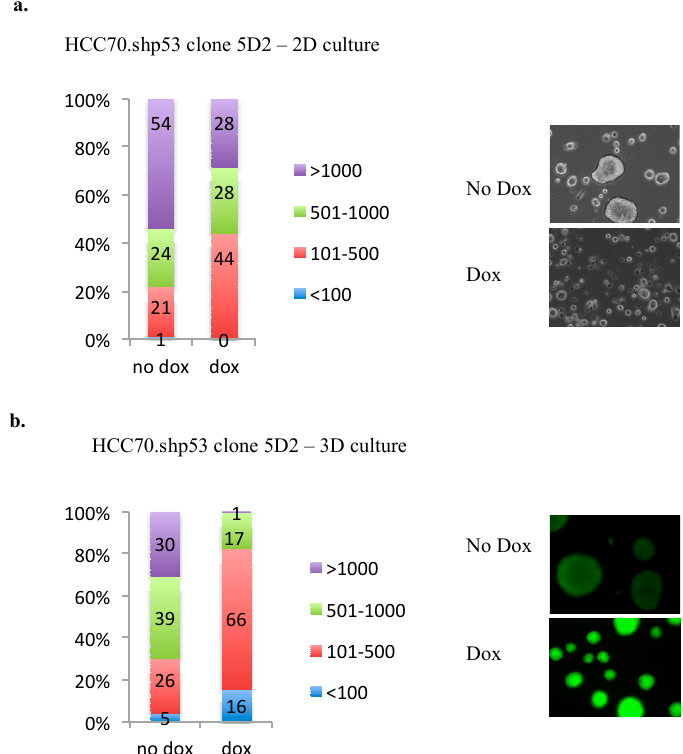
Figure 8. HCC70 colony size is reduced by the knockdown of R248Q mtp53. ( a ) Colony size of HCC70. shp53 clone 5D2 treated with or without Dox, was quantified using ImageJ software and presented as a distribution of size grouped randomly into <100 (blue), 101–500 (red), 501–1000 (green) and >1000 (purple). 100 colonies were used in quantification and % colonies in each size group are presented in a bar graph.